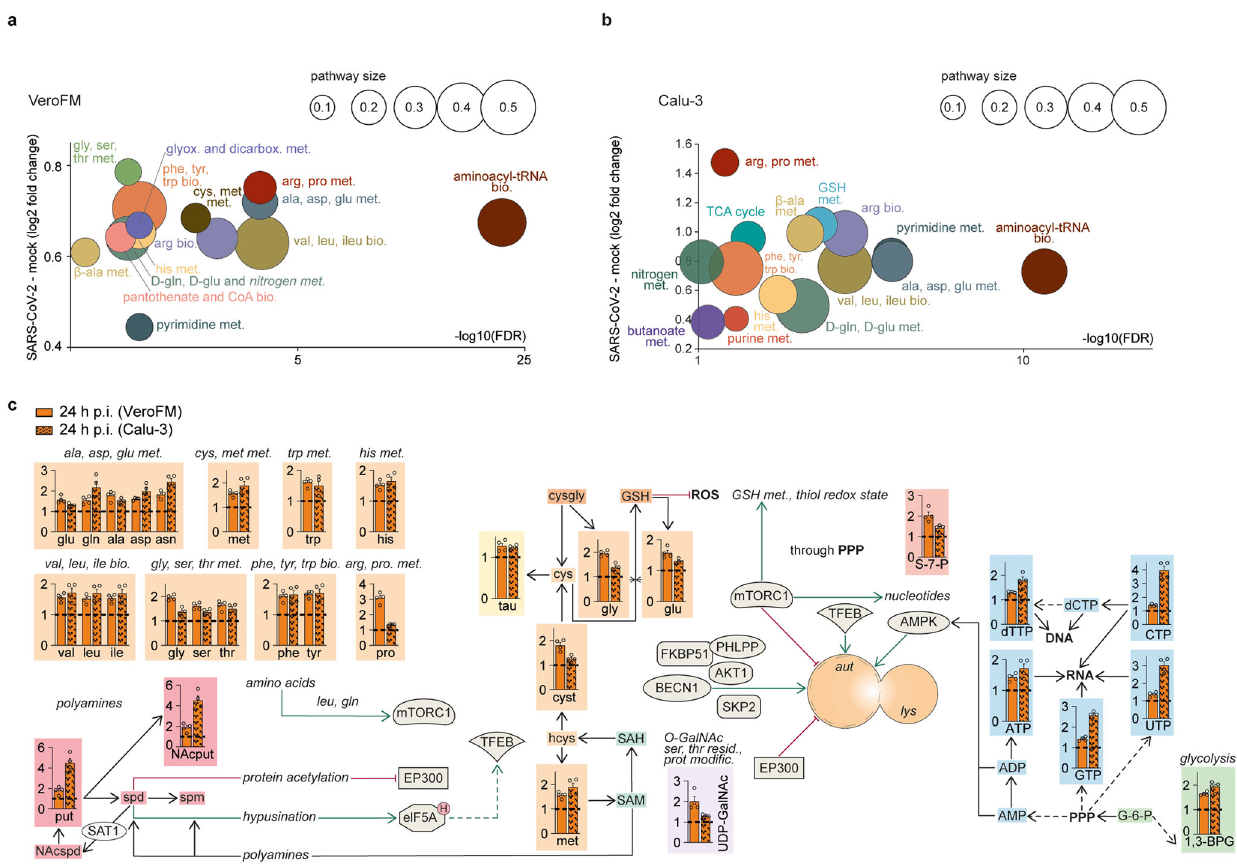
Fig. 1 SARS-CoV-2 causes accumulation of key metabolites in infected cells. a , b Analysis and regulation of signi fi cantly altered pathways of mock- and SARS-CoV-2-infected (24 h p.i., MOI = 0.1) VeroFM cells ( a ) or Calu-3 cells ( b ). The y -axis shows the (median) log2 fold change (FC) of all signi fi cantly altered metabolites of the indicated pathway while the – log10 corrected p -value (false discovery rate (FDR)) is shown on the x -axis. The size of the circles illustrates the number of signi fi cantly changed metabolites in relation to all metabolites of a speci fi c pathway. c Analysis of the autophagic pathway and the involved metabolites: ‘ amino acids ’ and ‘ GSH metabolism ’ (orange), ‘ nucleotides ’ (blue), ‘ glycolysis ’ (green), ‘ polyamine metabolism ’ (red) and ‘ O- GalNAcylation ’ (purple) in mock- and SARS-CoV-2-infected (24 h p.i.) VeroFM and Calu-3 cells. For a – c Error bars represent SEM. n = 4 biological samples per group of one experiment. All p-values were determined by a two-way ANOVA and Tukey´s post hoc test. FDRs were adjusted using the Benjamini-Hochberg method. Abbreviations: 1,3-BPG, 1,3-bisphosphoglyceric acid; 3-PGA, 3-phosphoglyceric acid; ADP, adenosine diphosphate;